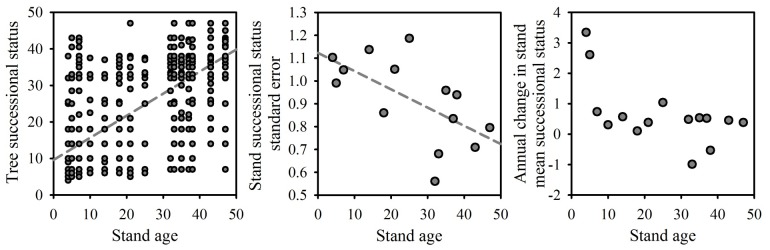
Linear relationship between stand age (years) and species successional status mean (years; left), standard error (SE; middle) and annual change (years; right).Stand values are calculated using all tree stems within each secondary forest stand.